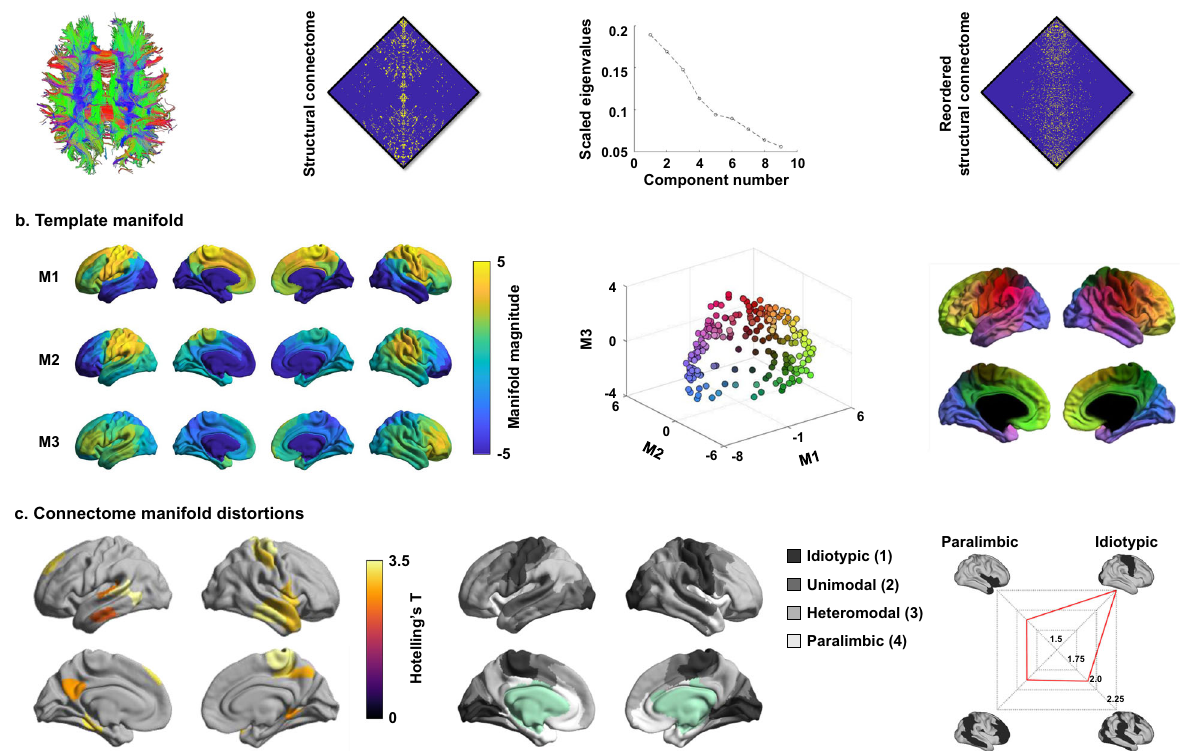
Fig. 1 Structural connectome manifolds. a Fiber tracts generated from dMRI (left), a cortex-wide structural connectome (middle left), and a scree plot describing connectome variance after identifying principal eigenvectors (middle right). The structural connectome reordered according to M1 is shown for better visualization (right). b Manifolds estimated from the structural connectome (left). Three dimensions (M1, M2, and M3) explained >50% of variance and corresponded to the clearest eigengap. Each data point (i.e., brain region) was represented in the three-dimensional manifold space with different colors (middle), and was mapped onto the brain surface for visualization (right). c The t-statistics of the identi fi ed regions that showed signi fi cant between- group differences in these dimensions between individuals with autism and controls (left). Findings have been corrected for multiple comparisons at false discovery rate (FDR) < 0.05. Strati fi cation of between-group difference effects along cortical hierarchical levels (middle) 62 is presented in the radar plot (right). Source data are provided as a Source Data fi